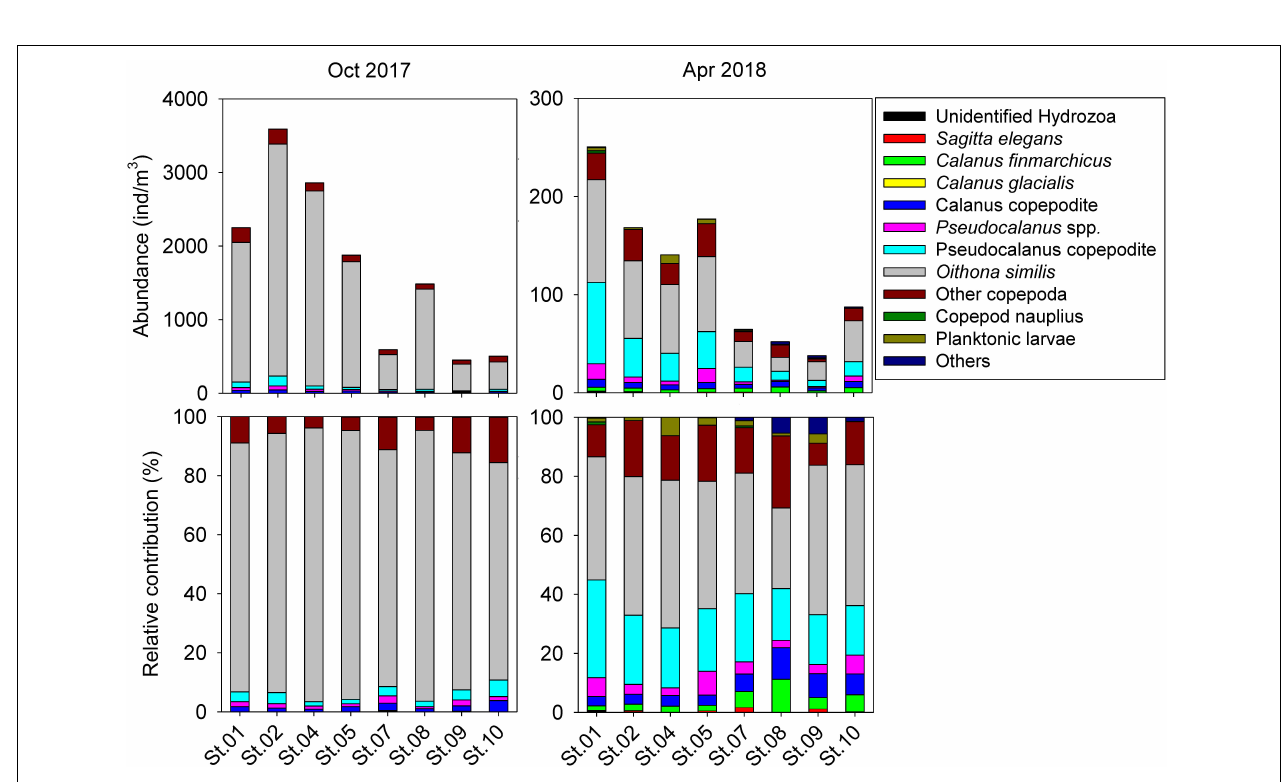
FIGURE 3 | Abundance and relative contribution of zooplankton of Kongsfjorden in October 2017 and April 2018.